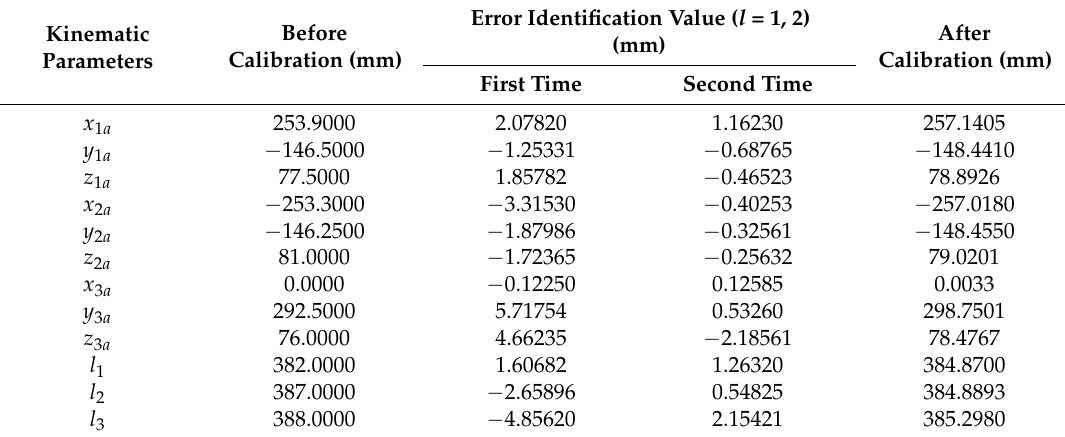
Table 8. The experimental results of kinematic